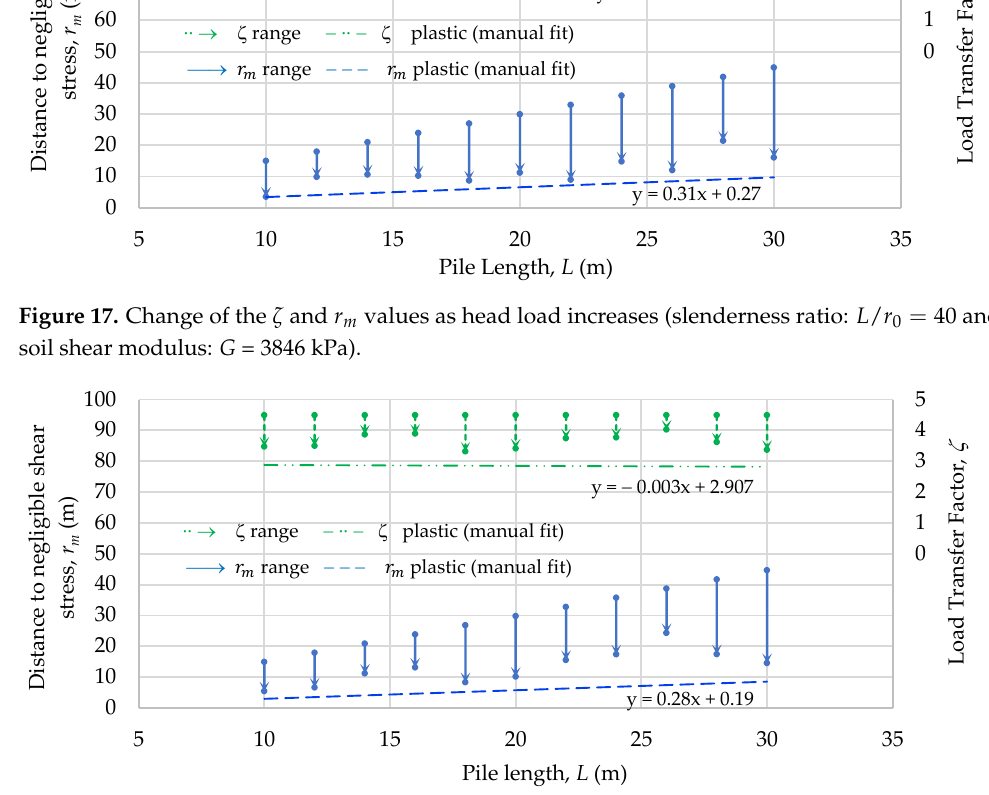
Figure 18. Change of the  and 𝑟 values as head load increases (slenderness ratio: 𝐿 𝑟 𝑚 Figure 18. Change of the  and 𝑟 𝑚 values as head load increases (slenderness ratio: 𝐿 𝑟 0 ⁄ = 60 and Figure 18. Change of the ζ and r m values as head load increases (slenderness ratio: L / r 0 = 60 and Figure 18. Change of the  and 𝑟 𝑚 values as head load increases (slenderness ratio: 𝐿 𝑟 0 ⁄ = 60 and soil shear modulus: G = 3846 kPa). soil shear modulus: G = 3846 kPa). soil shear modulus: G = 3846 kPa). soil shear modulus: G = 3846 kPa).